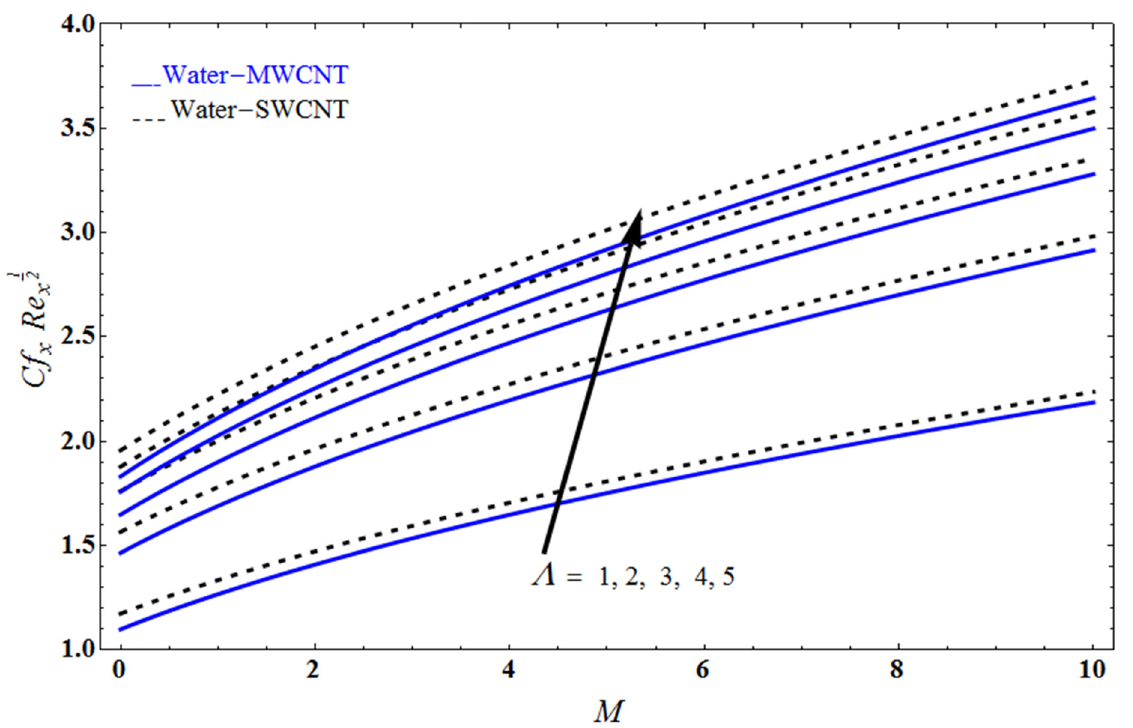
1/2 Re Cf M on for several values of c 1/2 Re on M for several values of V c , respectively. Cf M x x on for several values of c x x x